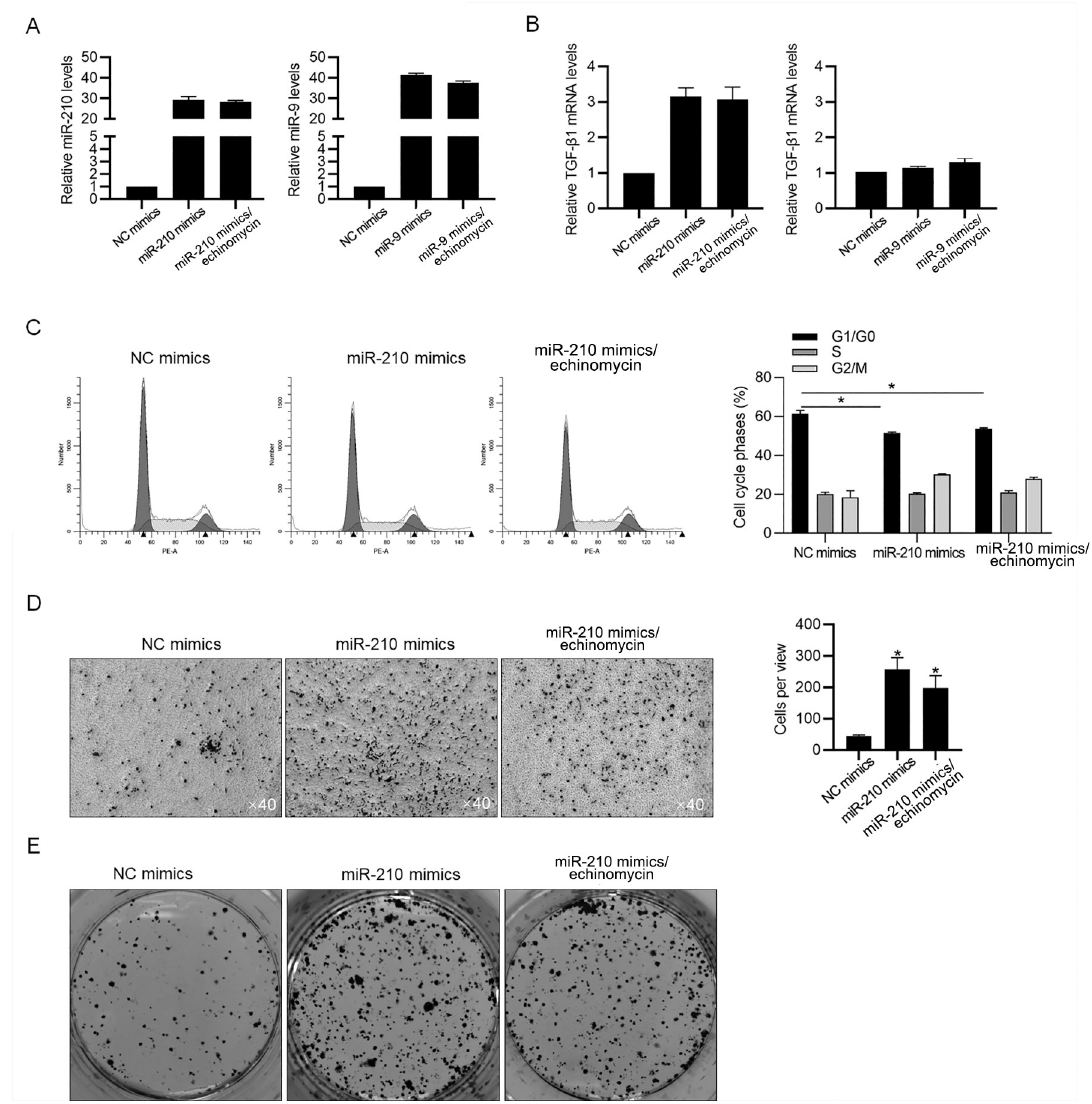
Fig 4. miR-210 mimics upregulated TGF- β 1 transcriptionally and promoted proliferation, invasion and colony formation abilities. A. After miR-210 mimics, or miR-9 mimics were transfected, RT-qPCR was performed to detect the amount of overexpressed miR-210 or miR-9. B. The TGF- β 1 mRNA level was measured by performing RT-qPCR. C. Cell cycle was measured by performing PI staining followed by flow cytometric assay. � P < 0.05, NC mimics group. D. Invasion was measured by performing transwell assay. � P < 0.05, NC mimics group. E. Colony formation was performed to detect the tumor formation in